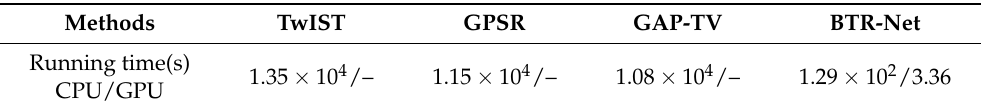
Table 2. Comparisons of running time (average time to reconstruct an HS image with a spatial resolution of 1280 × 1280 and 196 spectral